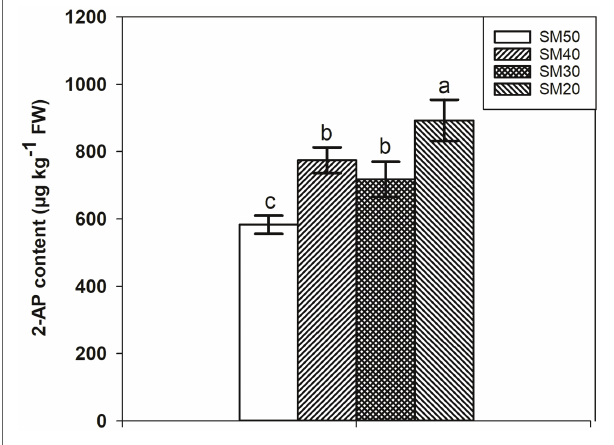
FIGURE 2 | Increase of 2AP content in fragrant rice with reduction of soil moisture. Each column represents the mean of three data ± standard error ( n = 3). Bars sharing a common letter do not differ significantly at p < 0.05.